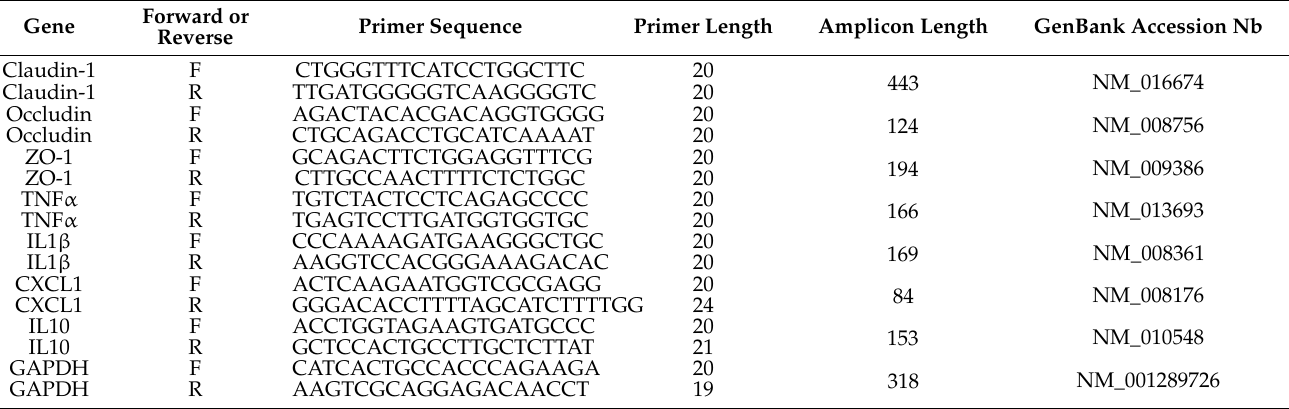
Table 1. Sequences of primers used for